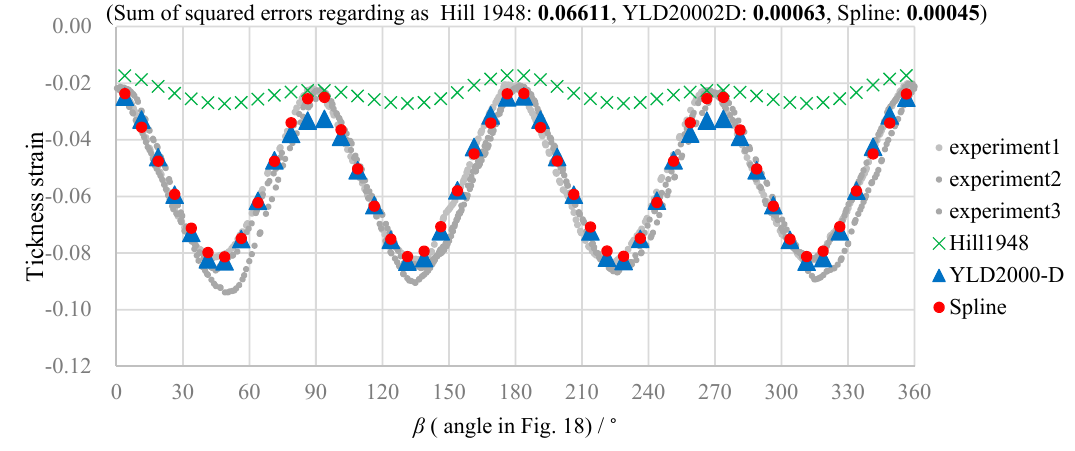
Figure 20. Comparison of thickness strain distributions on circle 2 in experimental condition A.